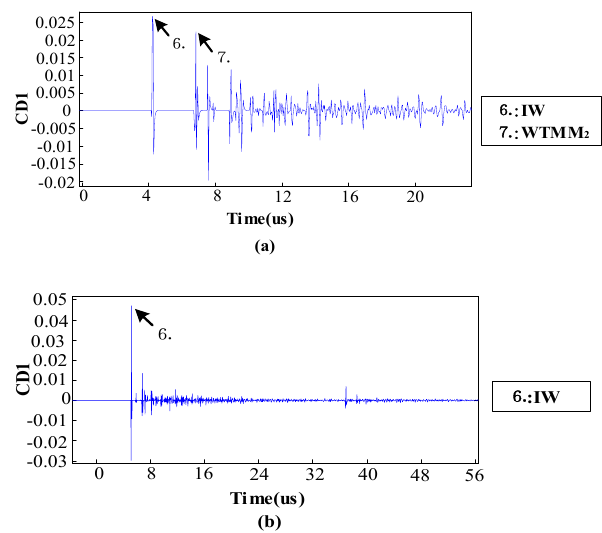
Figure 12. The voltage TWs and their aerial-mode components for a phase-to-ground fault at tee point 3. ( a ) The voltage TW measured at measurement unit 1; ( b ) The voltage TW measured at measurement unit 4; ( c ) The aerial-mode component of ( a ); ( d ) The aerial-mode component of ( b ).